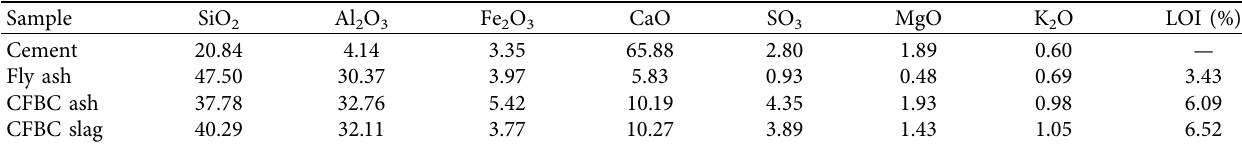
Table 2: Chemical compositions of cement, fly ash, CFBC ash, and CFBC slag (wt. %).